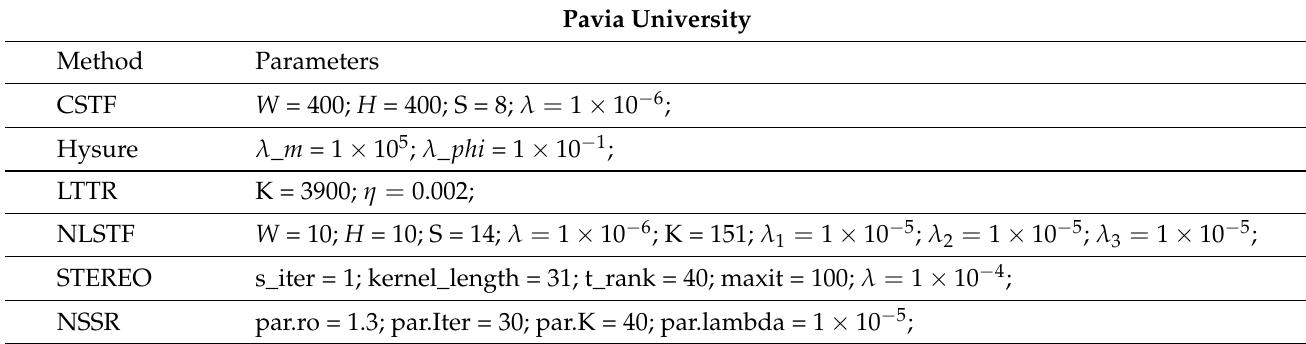
Table 1. Parameter settings on the Pavia University dataset.